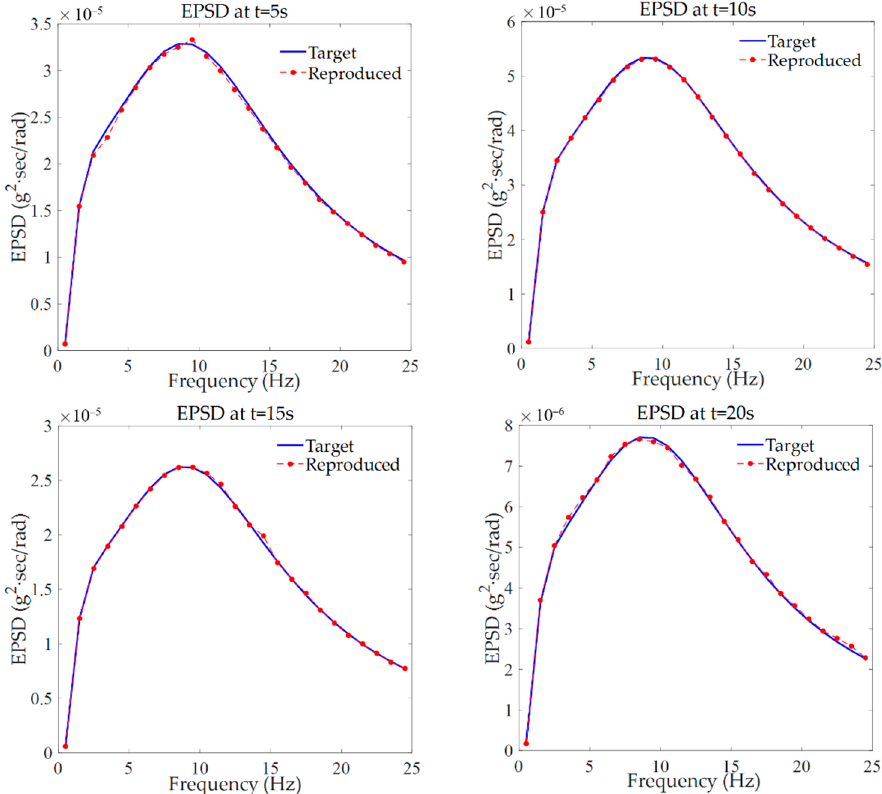
Figure 11. Comparations between the target and reproduced EPSDs at different frequency bands.